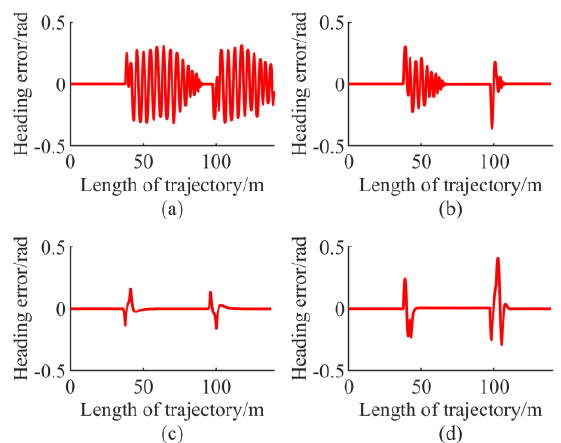
Figure 25. The heading error when parameters changed. ( a ) LMPC. ( b ) LEMPC. ( c ) NMPC. ( d ) NEMPC.